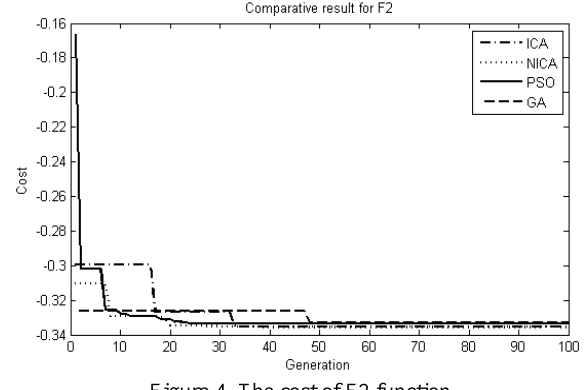
Figure 4. The cost of F2 function